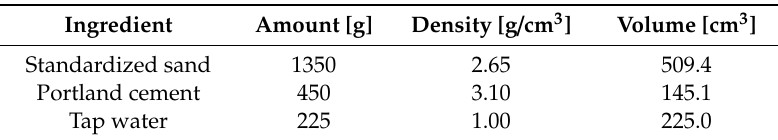
Table 1. Mixture composition for one